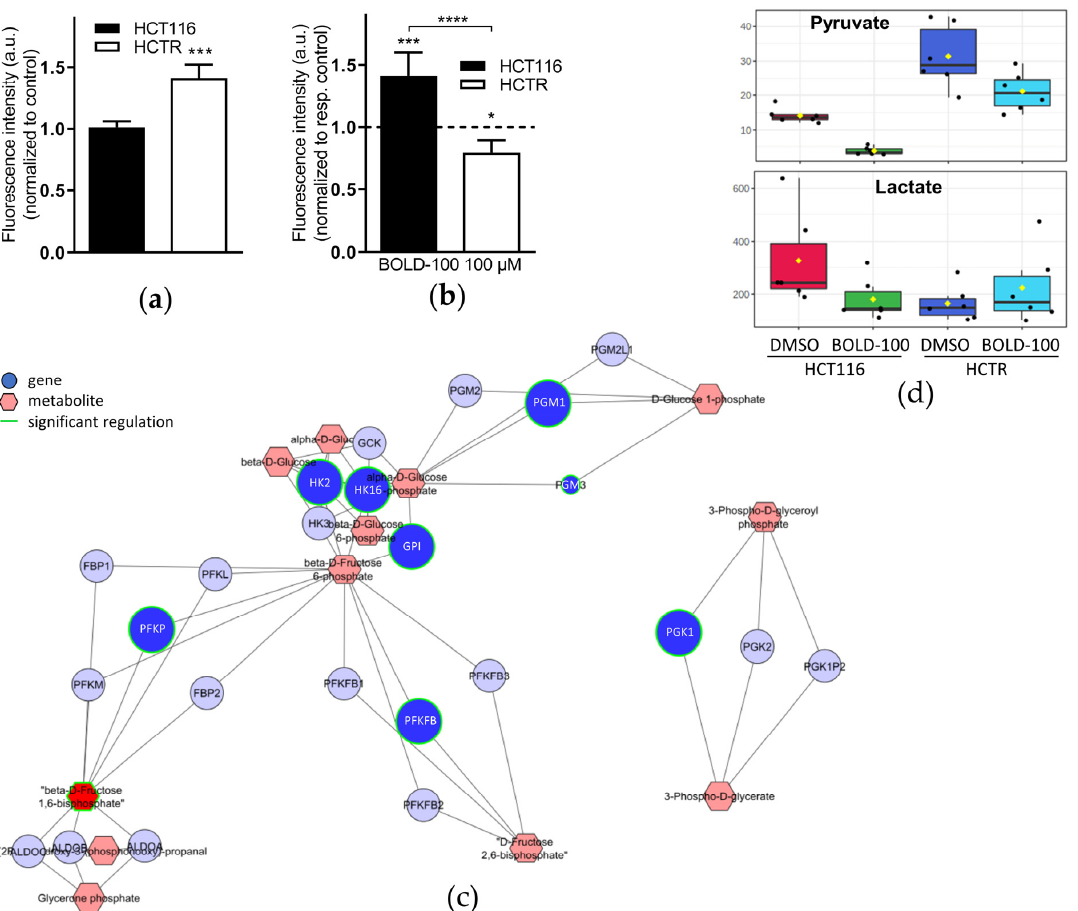
Figure 2. Acquired BOLD-100-resistant HCTR cells are characterized by enhanced glucose uptake and glycolytic activity, leading to increased intracellular pyruvate and decreased lactate levels. Flow cytometry analysis of fluorescence intensity of glucose-starved HCT116 and HCTR cells after 1 h of incubation with 25 µM 2-NBDG following treatment with solvent control ( a ) or 100 µM BOLD-100 ( b ) for 24 h. The results are the means of triplicates ± SD of two independent experiments. In ( b ) data are normalized to the respective control (dashed line). The statistical significance of differences was calculated with a two-tailed unpaired Student’s t -test ( a ) or a two-way ANOVA with Tukey´s multiple comparisons test ( b ): * p < 0.05, ** p < 0.01, *** p < 0.001, **** p < 0.0001. ( c ) Gene-metabolite network of whole genome gene expression data computed together with metabolomics data of HCTR vs. HCT116 cells. Dots and hexagons indicate regulated genes or metabolites, respectively. Differences in the color intensity correspond to the strength of gene expression change and the green fringe indicates significant regulation. ( d ) Metabolomics of HCTR vs. HCT116 cells with 24 h of treatment with DMSO or 100 µM BOLD-100; all metabolites in pmol/µg protein, n = 6 biological replicates. Together, the identified metabolic perturbations in cells with acquired BOLD-100 resistance led us to the hypothesis that the resistance phenotype might be characterized by novel metabolic vulnerabilities. Hence, glycolysis was inhibited pharmacologically with 2-DG and the effects on cell viability were assessed. Indeed, HCTR (Figure 3a) and CapanR (Figure S3a) cells were distinctly hypersensitive to 2-DG, while inhibition of glutaminolysis with BPTES [56] did not lead to any differences (Figure 3b). This suggests that HCTR cell survival depends on a functional glucose metabolization but not on